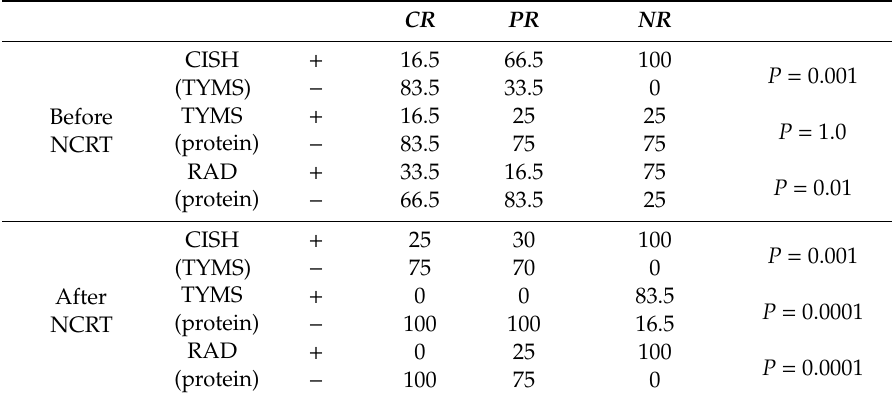
Table 3. Expression profiles of RAD23B and TYMS proteins and TYMS